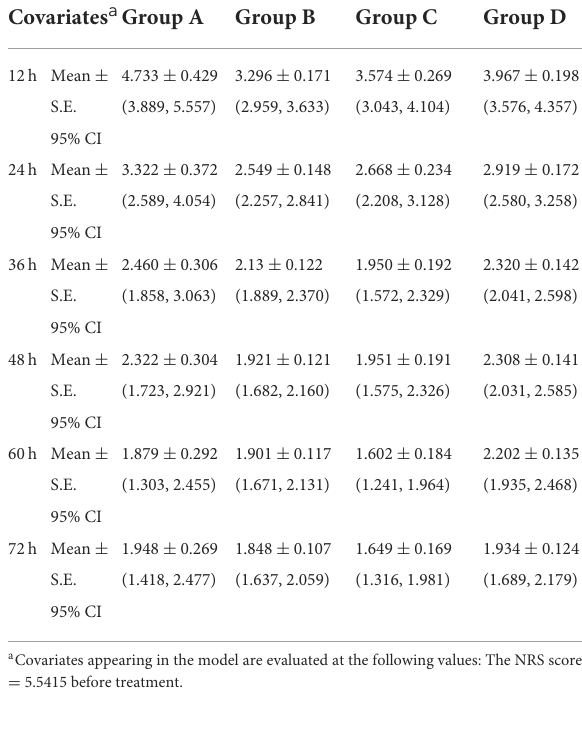
TABLE 2 Pain remission rates at 12h after treatment, and complete pain remission rates at 24h after treatment.